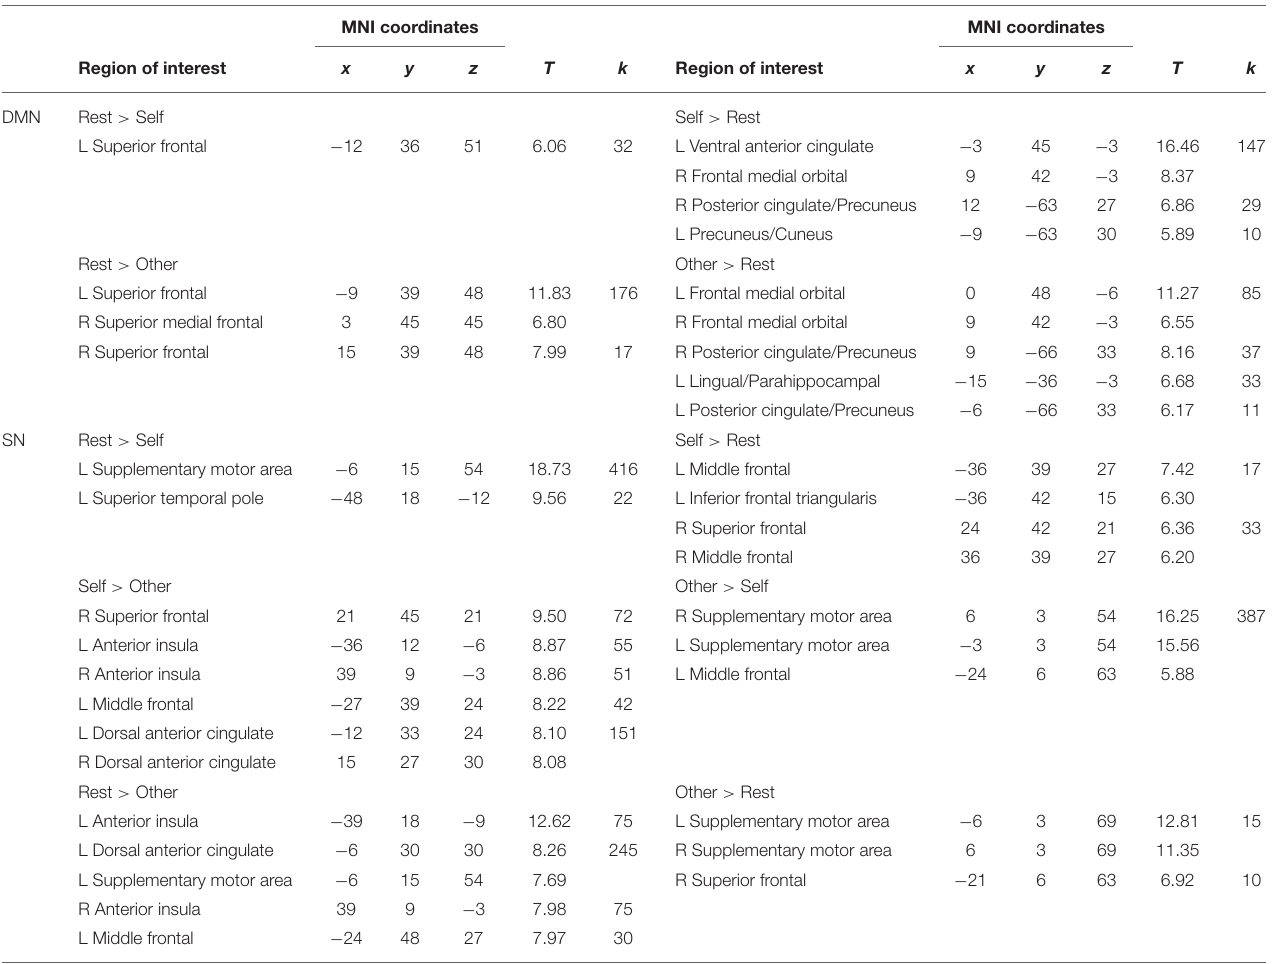
TABLE 3 | Differences in the DMN and SN’S functional connectivity between